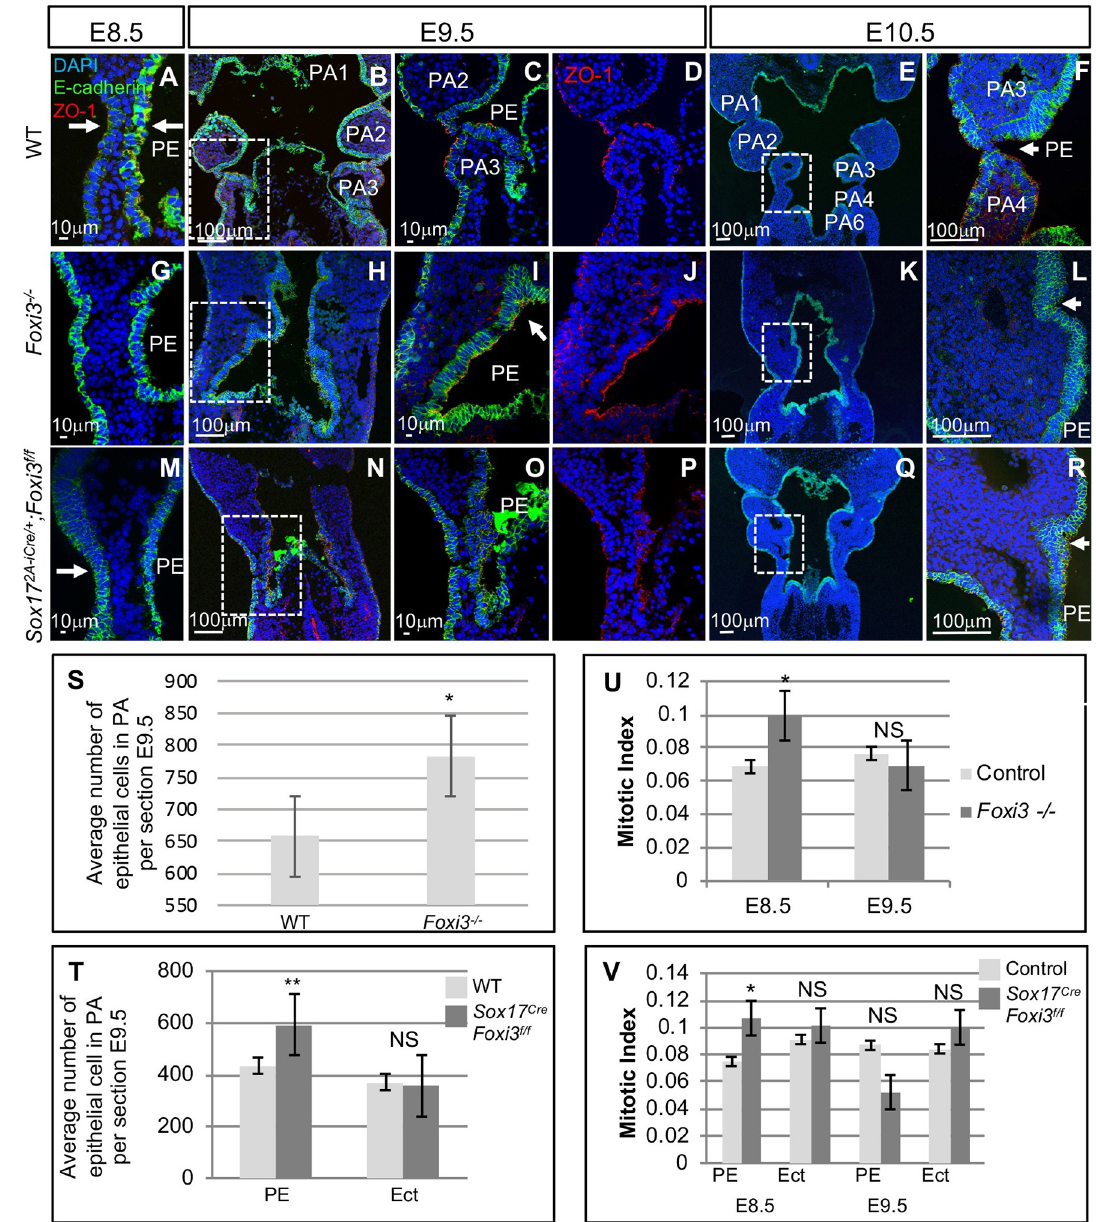
Fig 6. Foxi3 -/- and Sox17-2A-iCre/+;Foxi3 f/f mutant embryos have defects in PA segmentation. (A-R) DAPI (blue), E-cadherin (green), and ZO-1 (red) mark epithelial cells on coronal sections from WT (A-F), Foxi3 -/- (G-L) and Sox17 2A-iCre/+ ;Foxi3 f/f (M-R) embryos from E8.5-E10.5 (n = 4, each). White boxes indicate the location of higher magnification images. White arrows indicate where invagination occurs in the PE and ectoderm. (S-T) Quantification of epithelial cells within the PA at E9.5 in WT controls and mutant embryos. Error bars represent standard error. One asterisk indicates P-value < 0.05; two asterisks indicate P-value < 0.005 (n = 4, each). (U-V) Quantification of proliferation assays includes counting E-cadherin positive epithelial cells within the PA and calculation of the mitotic index, which is the ratio of pH3 positive cells within the E-cadherin positive epithelial cells. Error bars represent standard error, and asterisks indicate P-value < 0.05. Pharyngeal endoderm (PE) and ectoderm (Ect) were quantified separately in conditional mutant embryos. At E8.5 and E9.5 a total of n = 6 and n = 4, were examined, respectively, for control and mutant embryos. Controls include WT, Foxi3 +/- , and Sox17 2A-iCre/+ ;Foxi3 f/+ littermates.